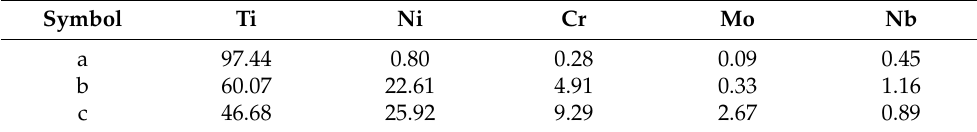
Figure 7. SEM of the central region ( A ) Phase morphology diagram. ( B ) Local enlargement of phase microstructure. Table 5. Element content at the mark (wt%).